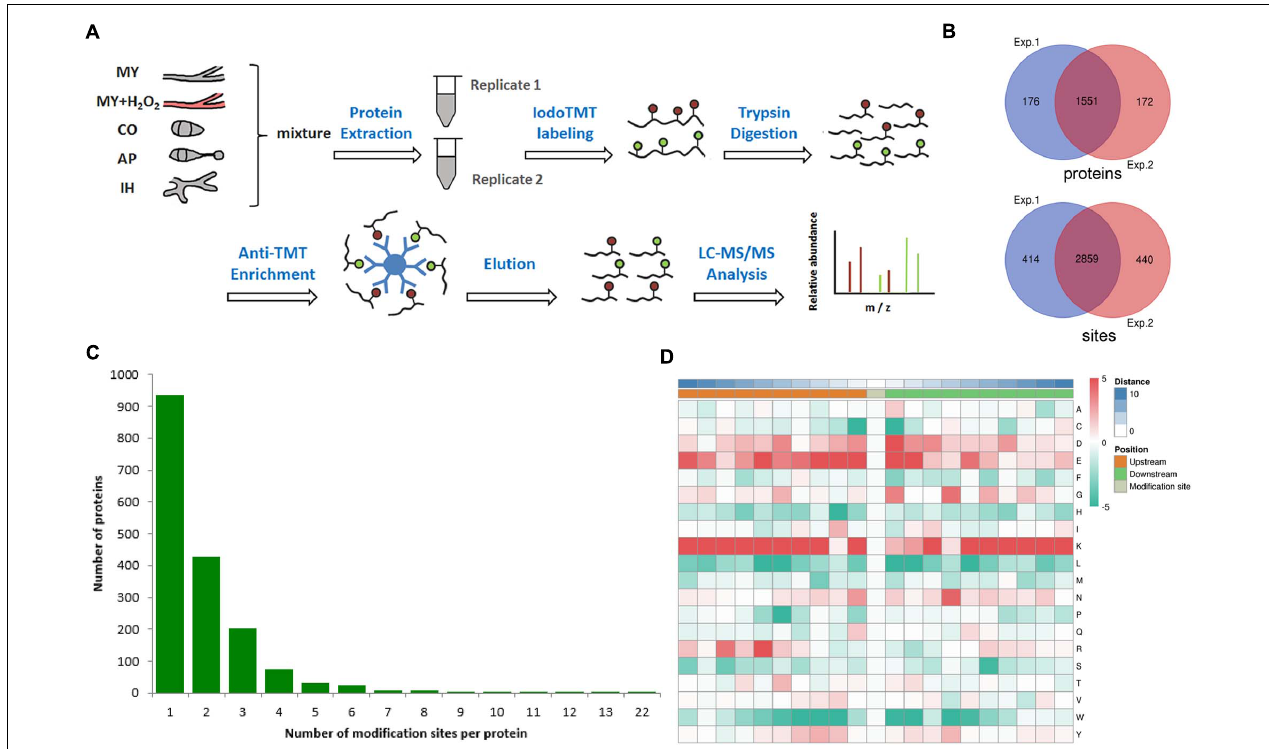
FIGURE 1 | Redox proteomics identification of thiol-modified proteins in M. oryzae . (A) Flow chart of the integrated strategy for quantitative analysis of the redox proteome. (B) Venn diagram of modified proteins identified in replicates. (C) Venn diagram of modified sites identified in replicates. (D) The motif enrichment heatmap of upstream and downstream amino acids of all identified modification sites. Red and green indicate that this amino acid is more and less abundant close to the modification site.